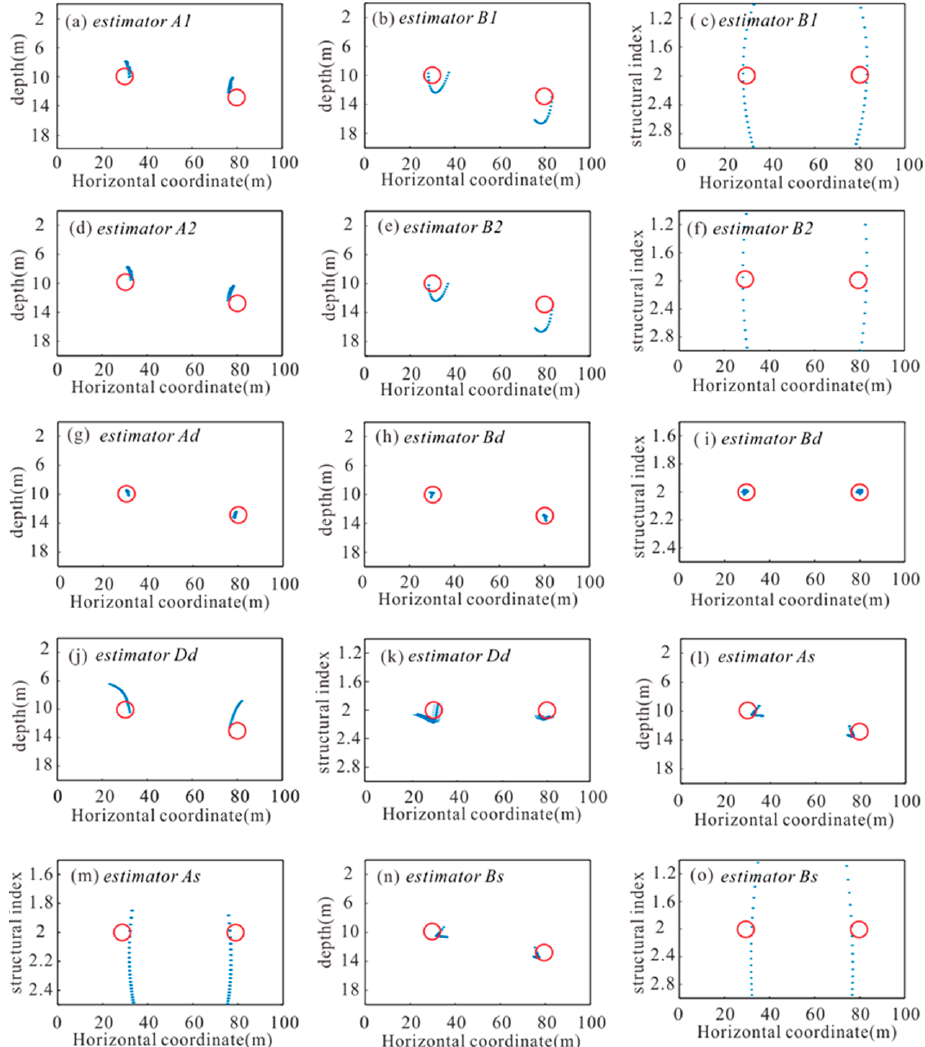
Figure 2. ( a ) Source location results generated by estimator A1 after screening; ( b ) source